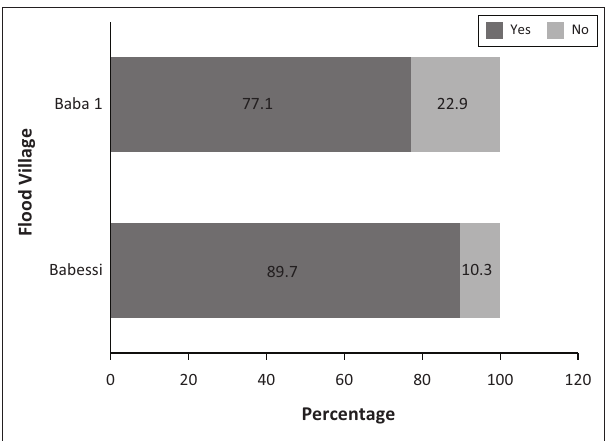
FIGURE 2: Household membership in groups and/or networks.